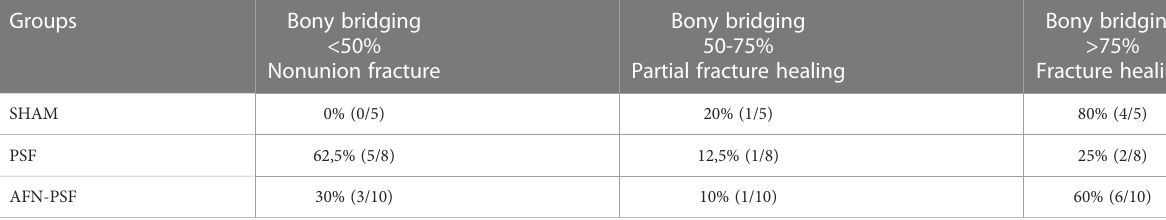
TABLE 1 Percentage of bony bridging of the fracture site. Groups